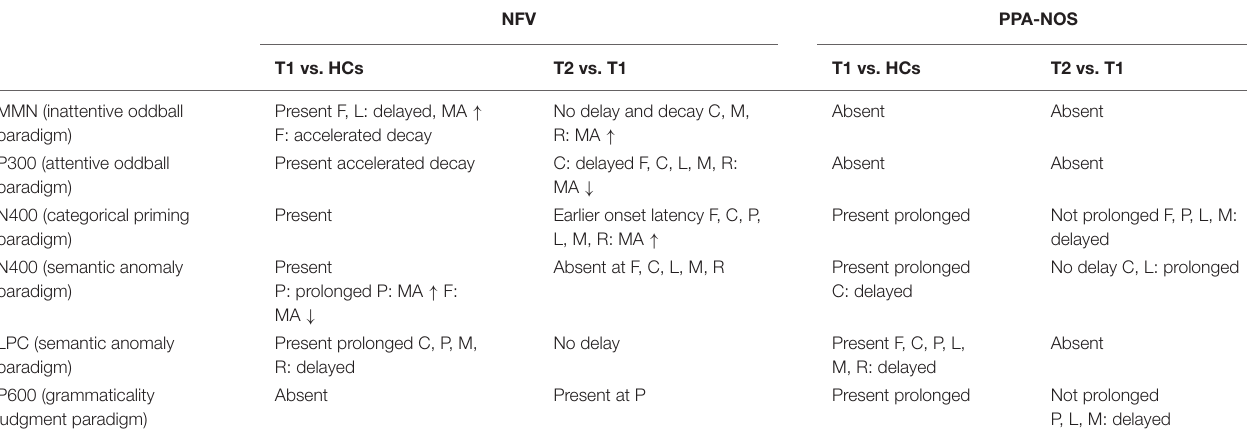
TABLE 3 | The electrophysiological results of each ERP component in the patients with NFV and PPA-NOS who received SLT at the initial assessment and the follow-up